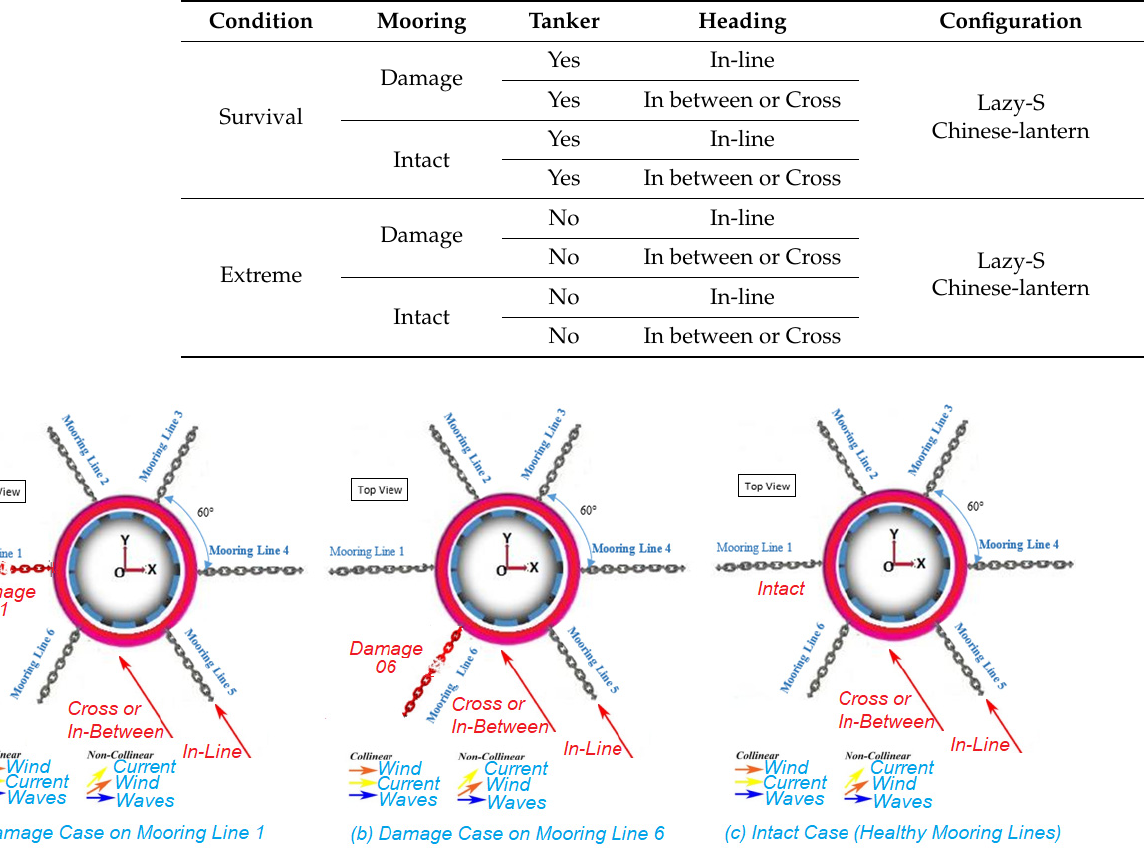
Figure 10. The description of the mooring conditions for the load cases applied in the hose analysis, showing ( a ) damaged mooring line 1, ( b ) damaged mooring line 6 and ( c ) intact mooring.